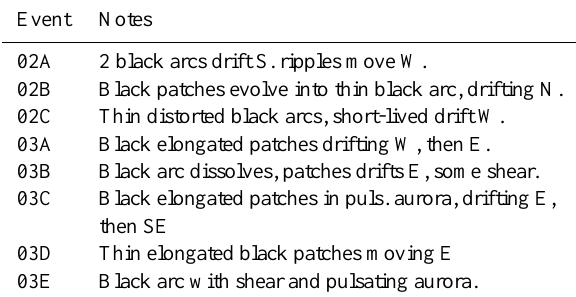
Table 2. Visual characteristics of each